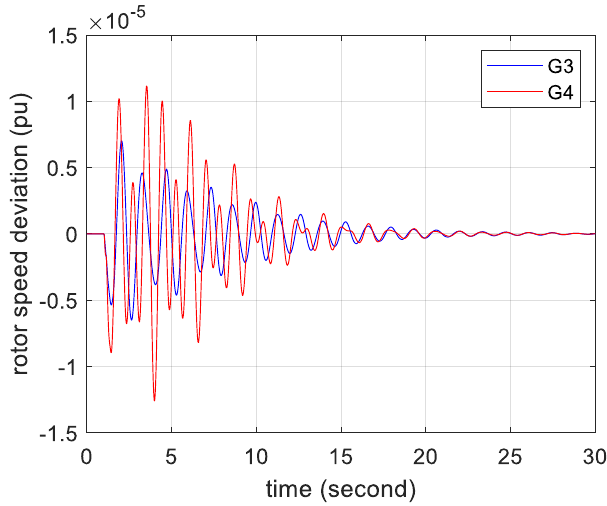
Figure 16. Rotor speed responses under WECS and BESS controller failure. Table 4. Damping performance of interarea mode with high RESs.